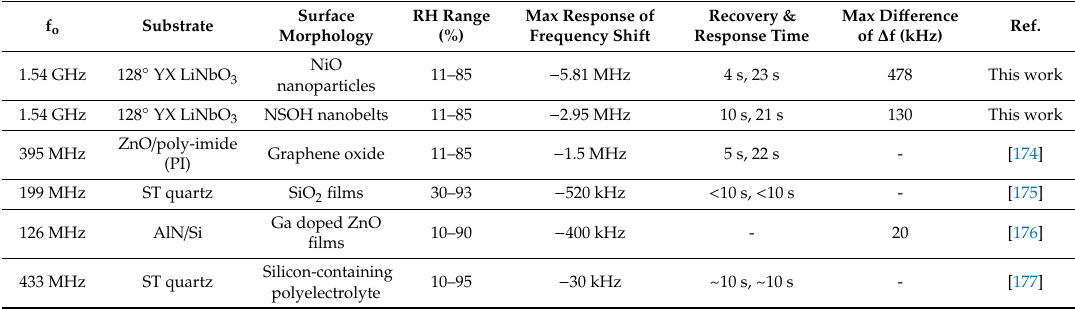
Table 3. Comparison of developed SAW sensors for relative humidity sensing with other strategies reported in literature, adapted with permission from [173].